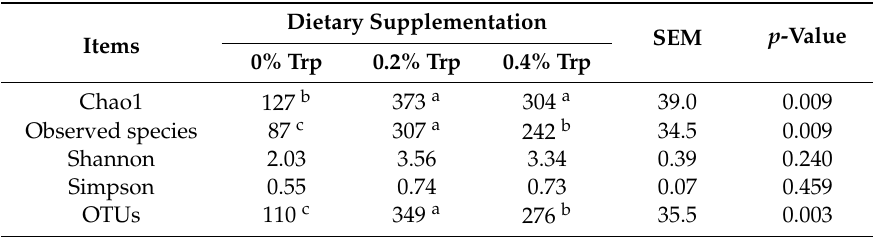
Table 2. Effects of dietary supplementation with Trp on the α diversity indices (Chao1, Observed species, Shannon, and Simpson) and OTUs 1 .